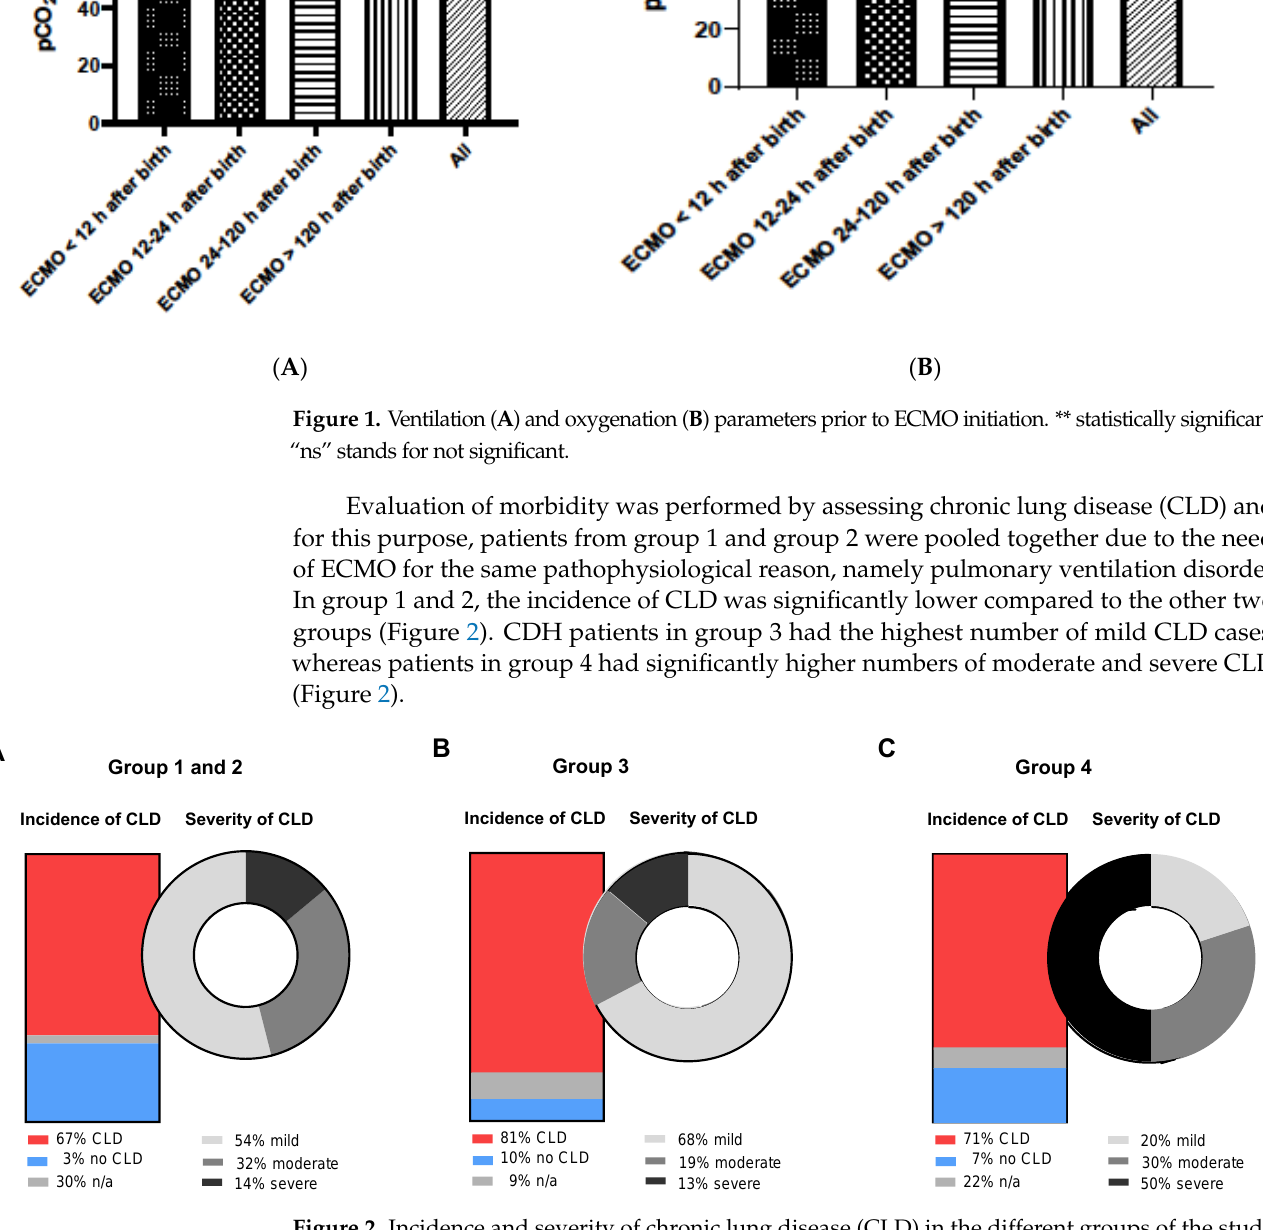
Figure 2. Incidence and severity of chronic lung disease (CLD) in the different groups of the study population: ( A ) group 1 (ECMO initiation <12 h after birth) and 2 (ECMO initiation 12–24 h after birth), ( B) group 3 (ECMO initi ation 24–120 h after birth) and ( C ) group 4 (ECMO initiation 120 h after birth).